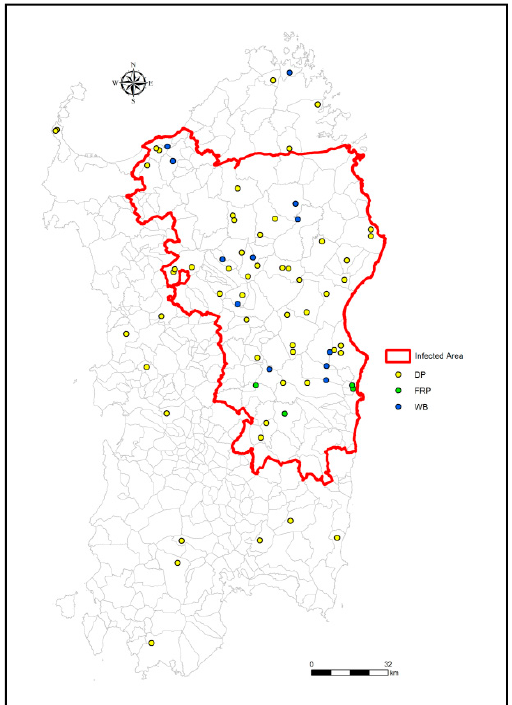
Figure 1. ASF outbreaks occurred in Sardinia in all the host populations of domestic pigs, wild boar, and free-ranging pigs between 1978 and 2020. Data are extracted from official reports recorded in the Italian National Information System for the Notification of Infectious Animal Disease (SIMAN) database, including both outbreaks confirmed for virus isolation and those for epidemiological correlation, according to the World Organization for Animal Health (OIE) Terrestrial Manual.